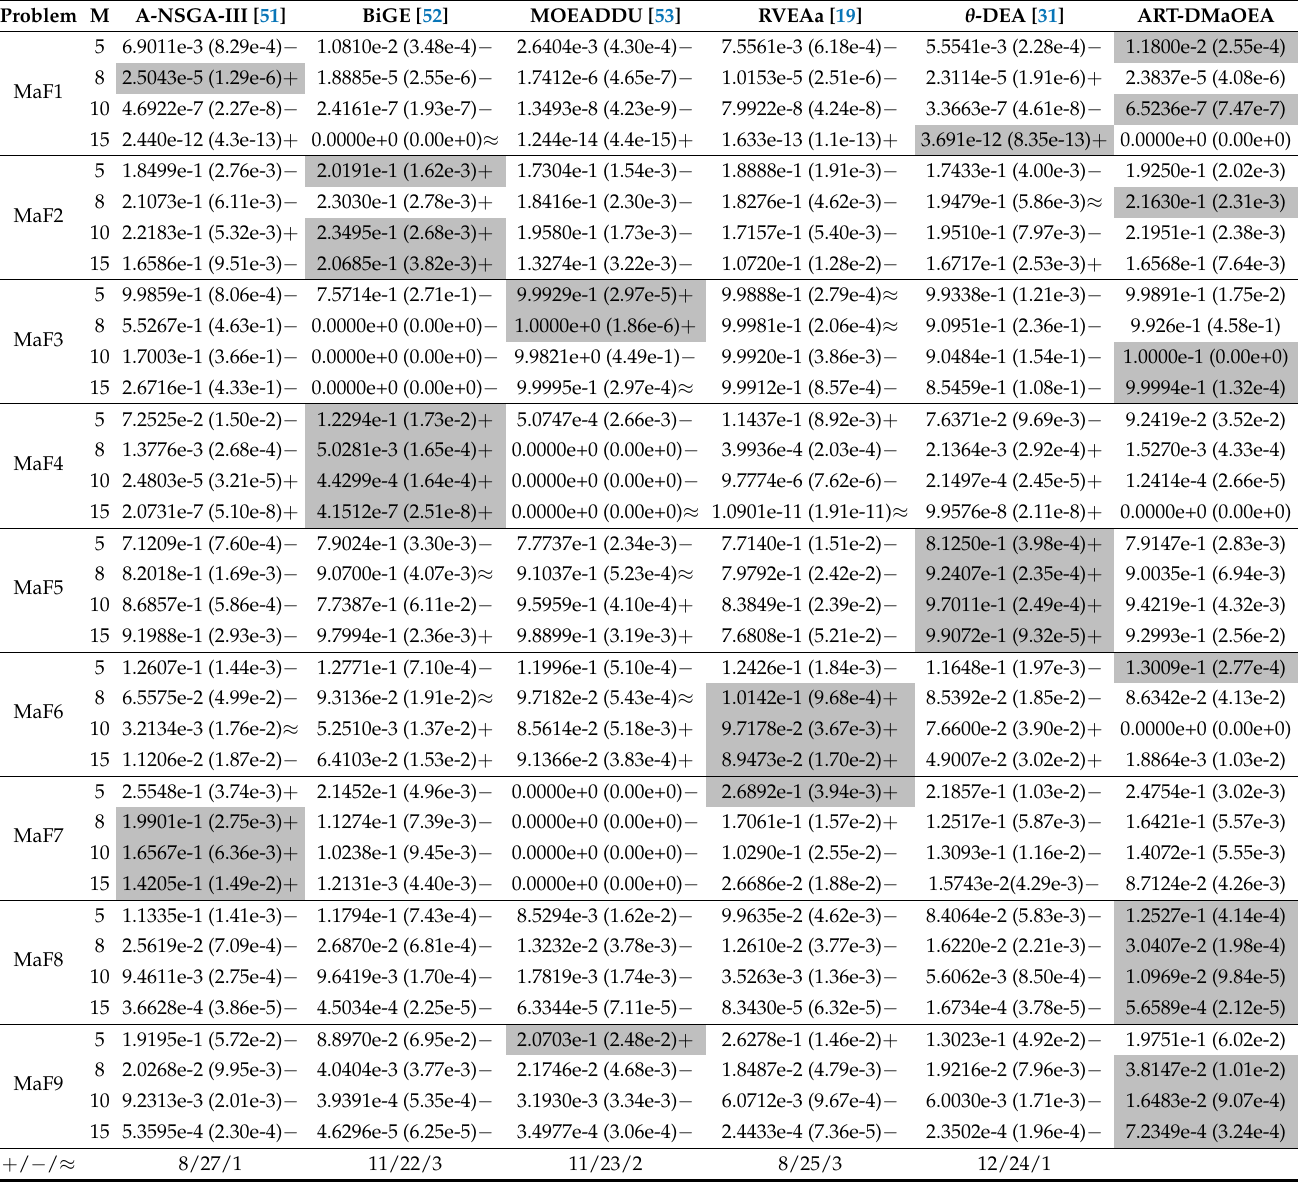
Table 1. HV Results of the sex algorithms on benchmarks